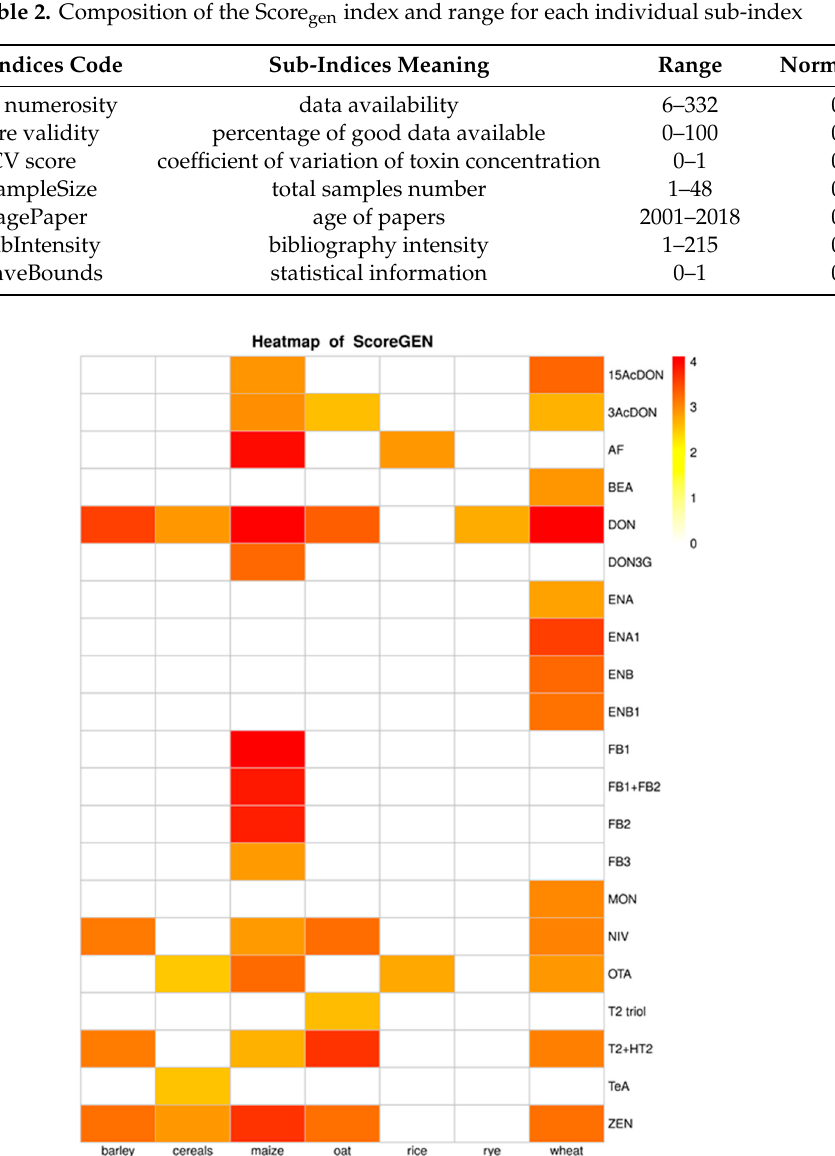
Table 2. Composition of the Score gen index and range for each individual sub-index